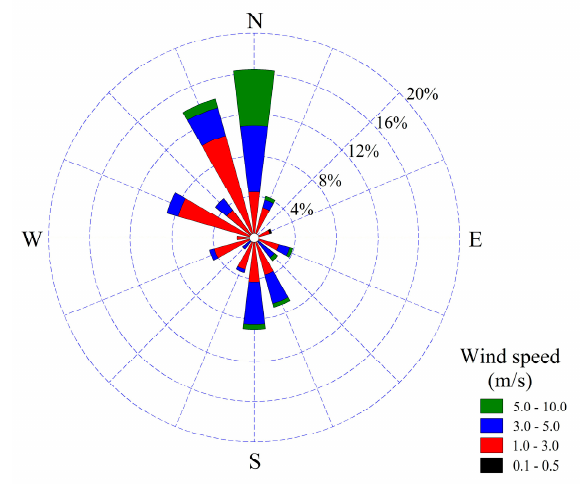
Figure 8. Long-term statistics of wind measured at an altitude of 10 m in Podgorica, in the proximity of the proposed FPPP.